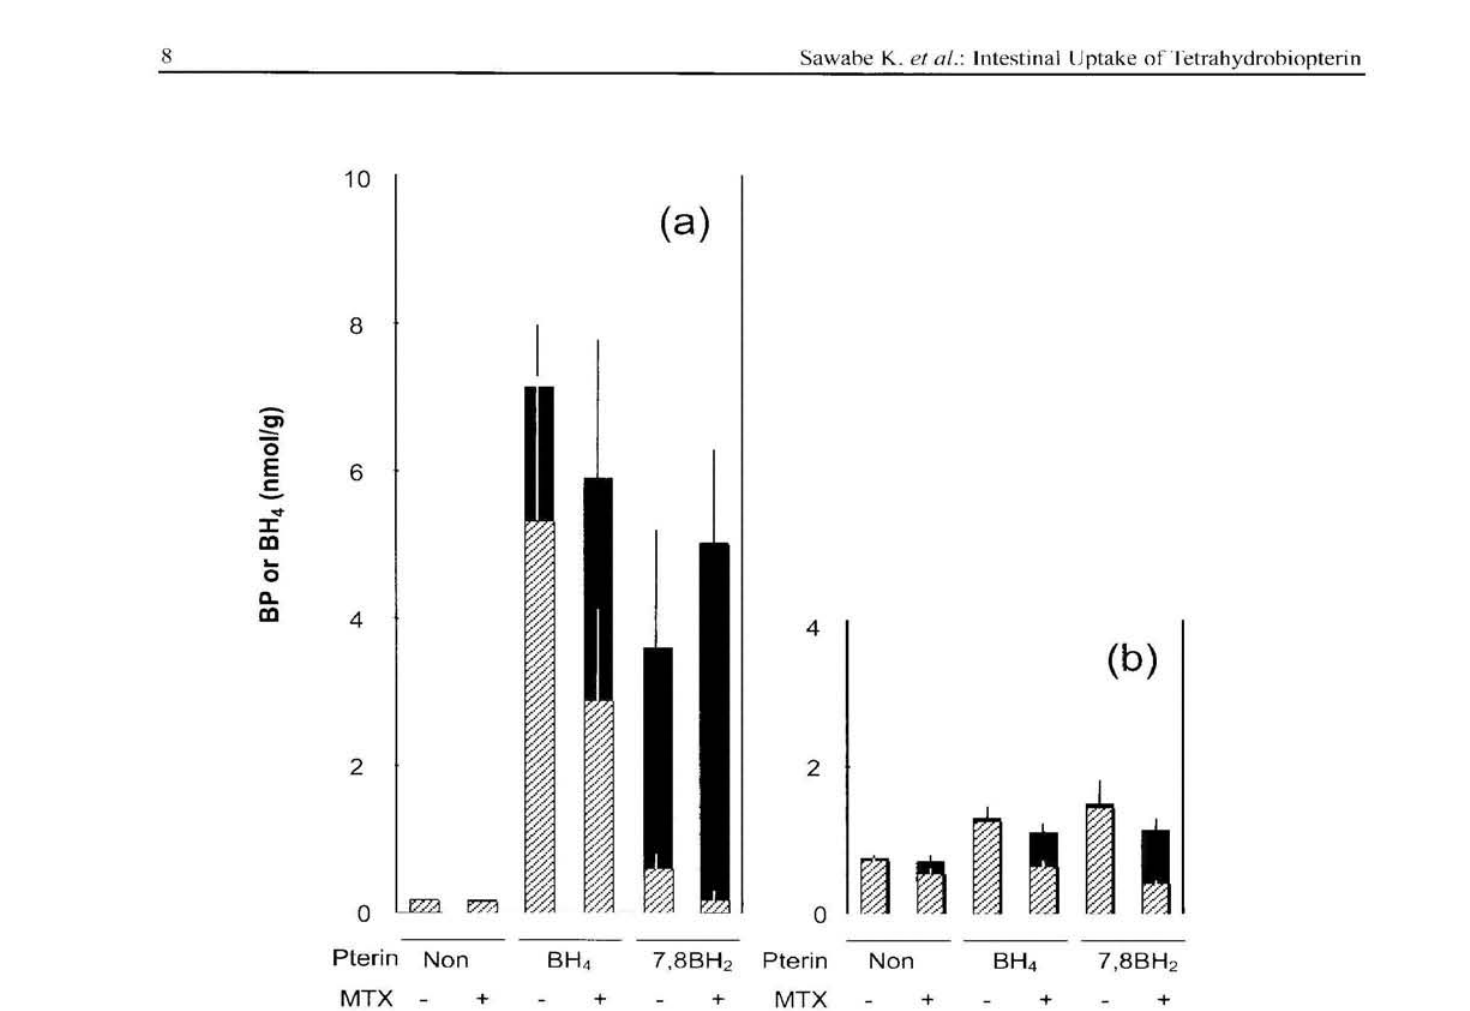
Figure 1. Methotrexate (MTX) inhibition of BH 4 accumulation in the liver and small intestine after oral admin- istration of 6RBH 4 and 7,8BH 2 . MTX (10 mg/kg) was given 90 min before oral administration of the pterins. Pterins were administered at the same dose of 10 mg/kg body weight. Organs were dissected out 30 min after the pterins were administered. Tissue biopterin levels were measured in the small intestine (proximal 1/3) (a) and the liver (b). The height of bars represents the total biopterin. BH 2 (closed bar) and BH 4 (hatched bar) were cal- culated as described in Materials and Methods. Data are mean ± SEM values